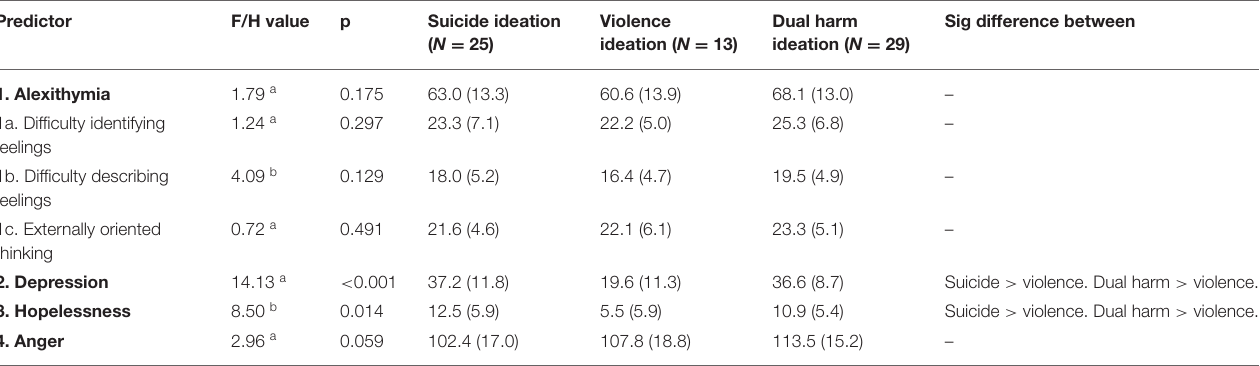
TABLE 3 | ANOVA of dual harm ideation. Predictor